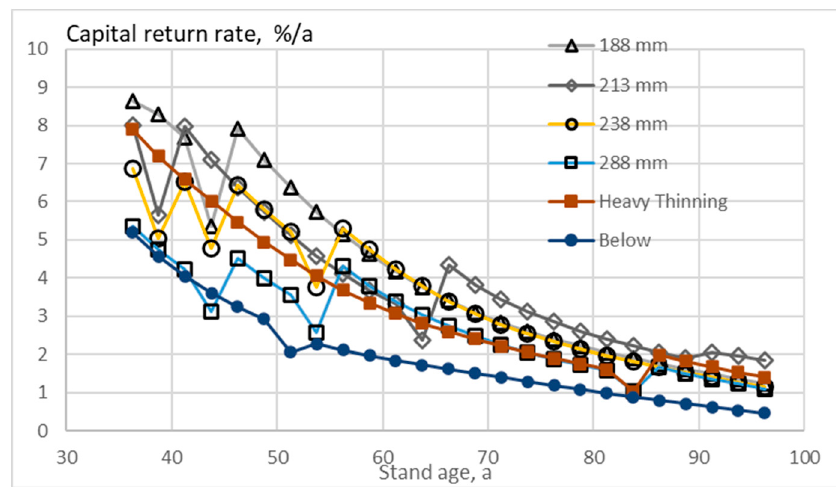
Figure 2. Capital return rate according to Equation (2) for six different treatments applied on a normal stand representing the example estate. The capital return rate is computed for any 30-month period, without integration over the site lifespan, and without considering any clearcutting price premium or clearcutting harvesting pricing.